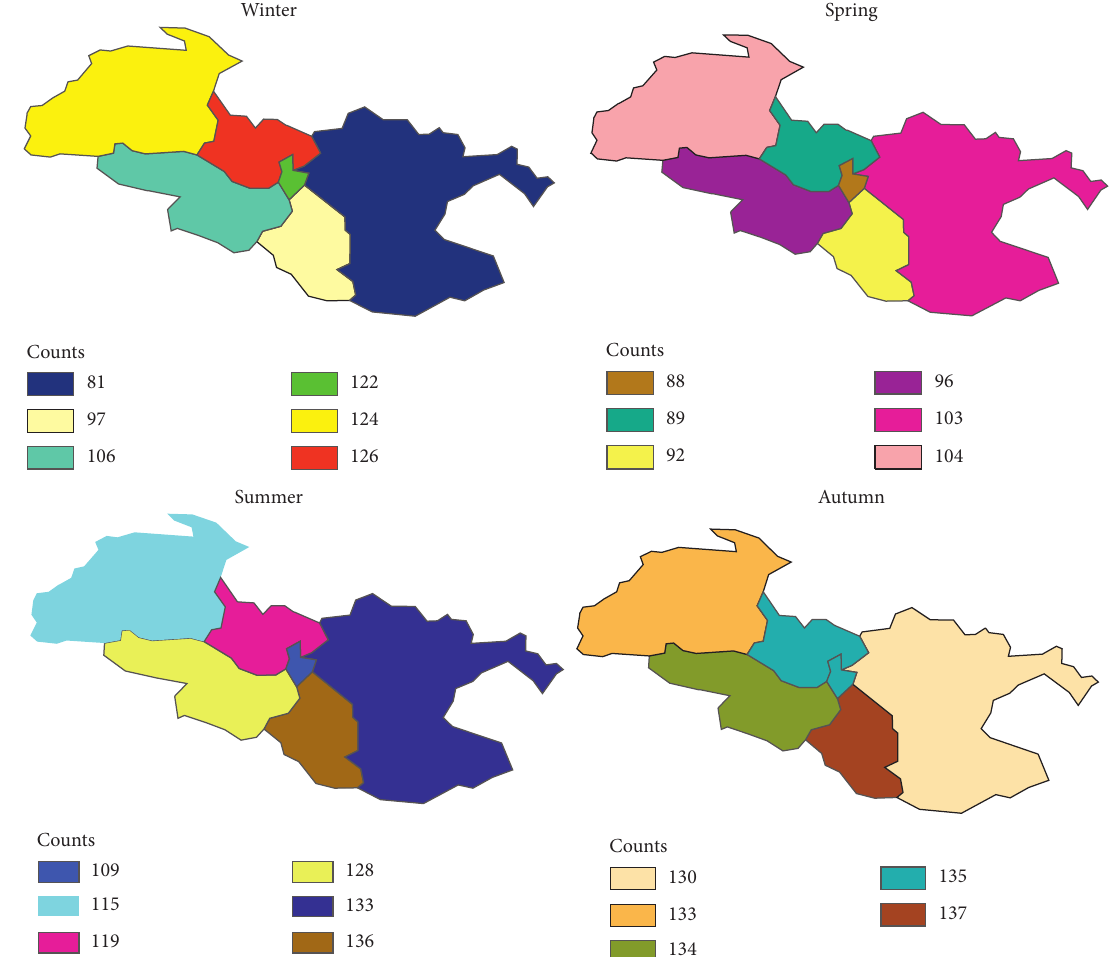
Figure 5: The total number of counts with SPI ≤ 1 in the selected stations for SPI-3 in various seasons.